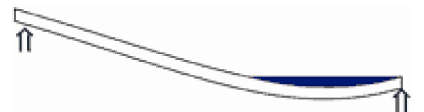
Fig. 6. A scheme showing the formation of swamps due to fitting errors (slope 1:40)